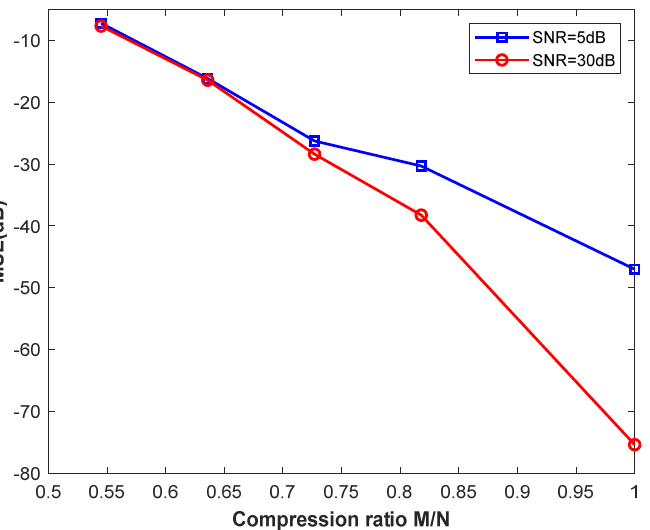
Figure 5. Frequency estimation mean square error versus compression ratio, the colored noise case, for SNR = 5 dB and SNR = 30 dB. 𝜔 (cid:3042) = 𝜋/8 = 0.393 rad, 𝛼 = 5, 𝐵 = 10, 𝑝 = 5,𝑞 = 10 .